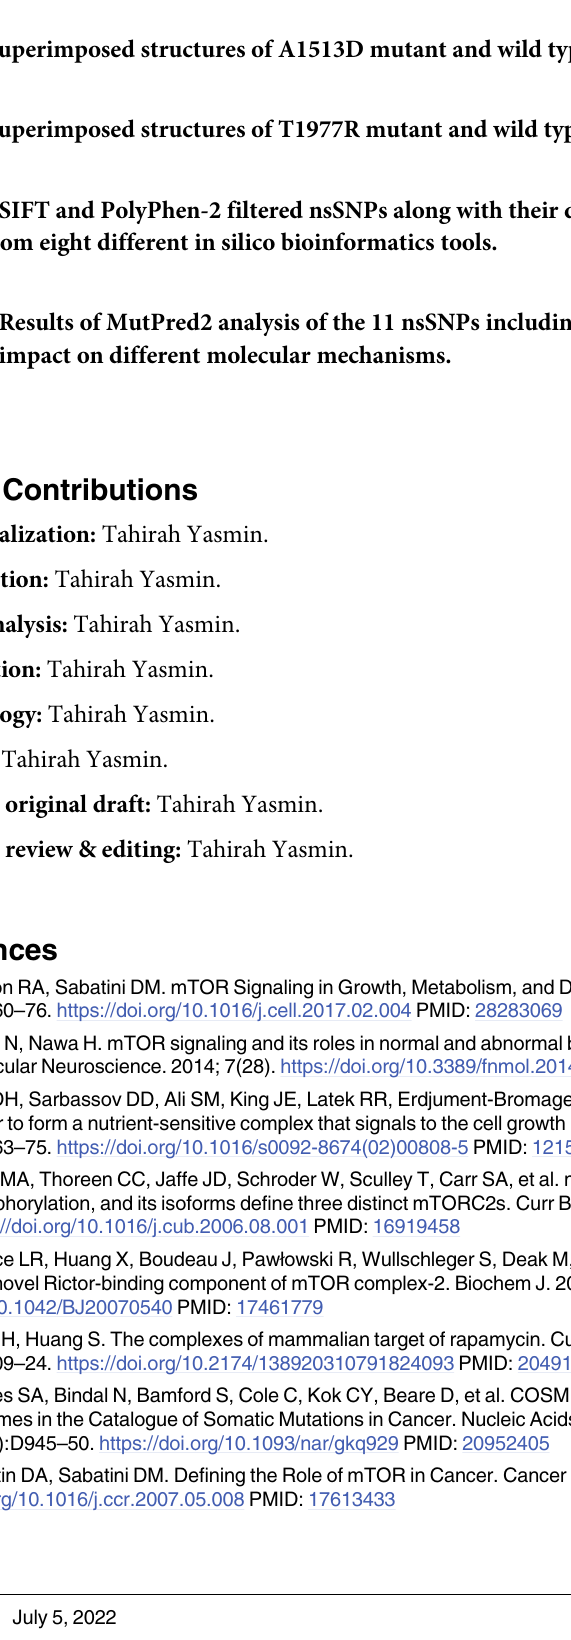
S14 Fig. Superimposed structures of R619C mutant and wild type mTOR protein. (TIF) S15 Fig. Superimposed structures of A1513D mutant and wild type mTOR protein. (TIF) S16 Fig. Superimposed structures of T1977R mutant and wild type mTOR protein. (TIF) S1 Table. SIFT and PolyPhen-2 filtered nsSNPs along with their dbSNP IDs and scores derived from eight different in silico bioinformatics tools. S2 Table. Results of MutPred2 analysis of the 11 nsSNPs including their MutPred2 score and their impact on different molecular